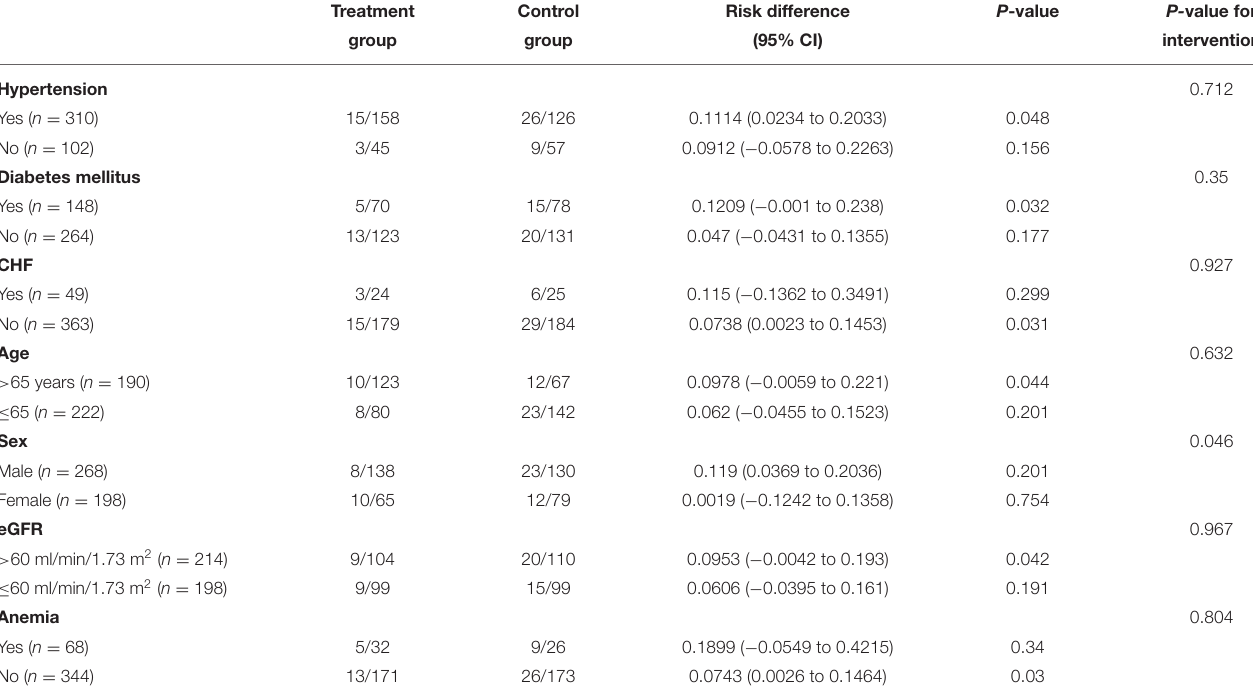
TABLE 4 | Occurrence of contrast-induced acute kidney injury in post-hoc subgroups. Treatment Control Risk difference P